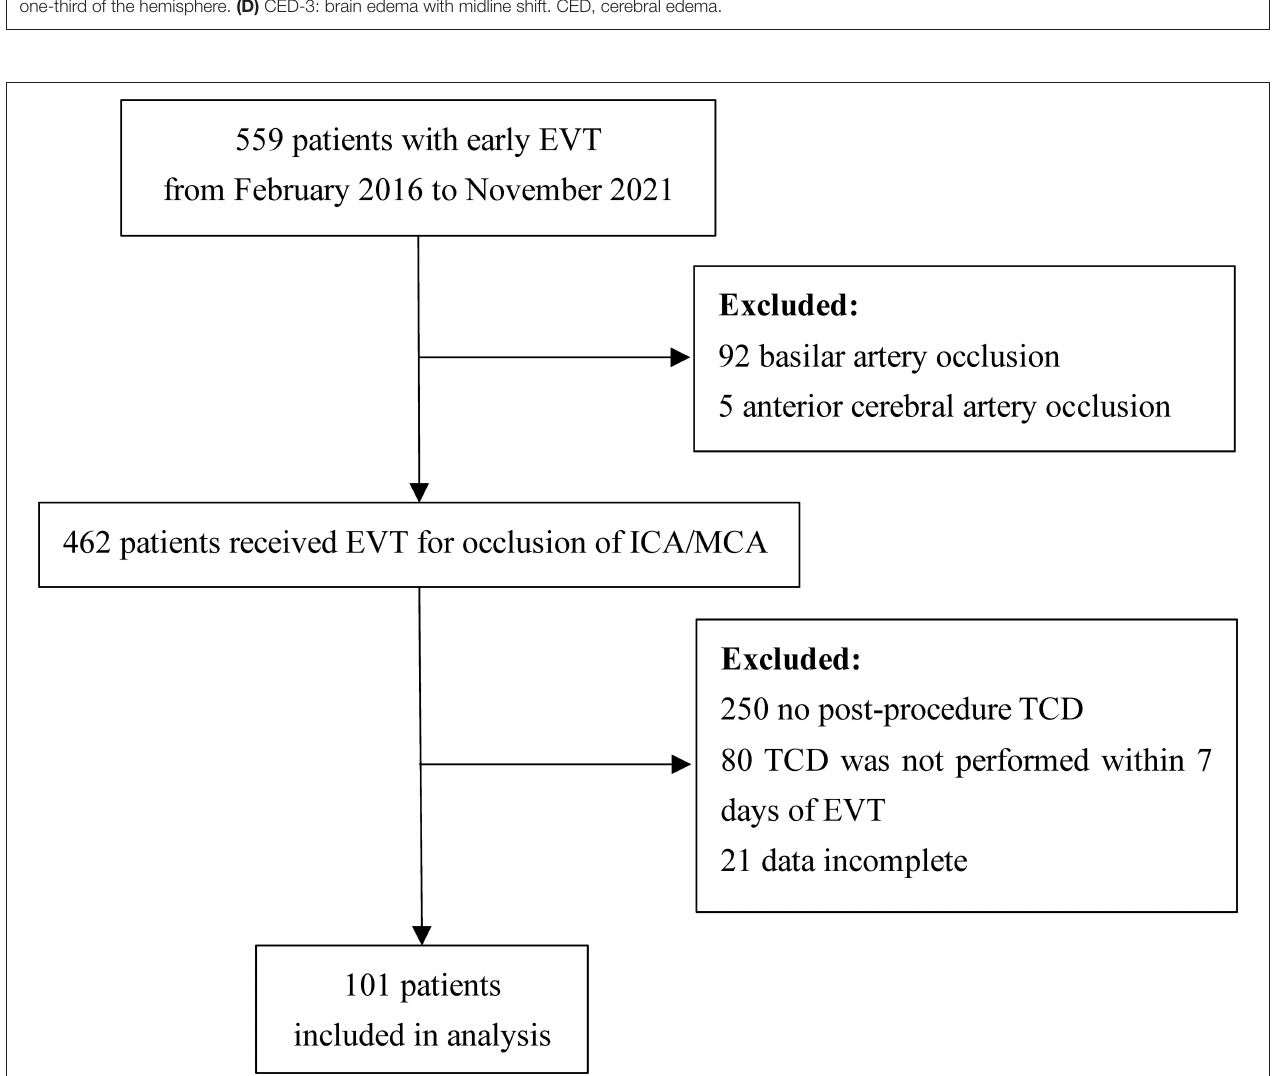
FIGURE 1 | Post-procedure computed tomography scans showing different severity of brain edema according to the Safe Implementation of Thrombolysis in Stroke-Monitoring Study (SITS-MOST). (A) CED-0: no edema. (B) CED-1: focal brain edema up to one-third of the hemisphere. (C) CED-2: brain edema greater than one-third of the hemisphere. (D) CED-3: brain edema with midline shift. CED, cerebral edema.